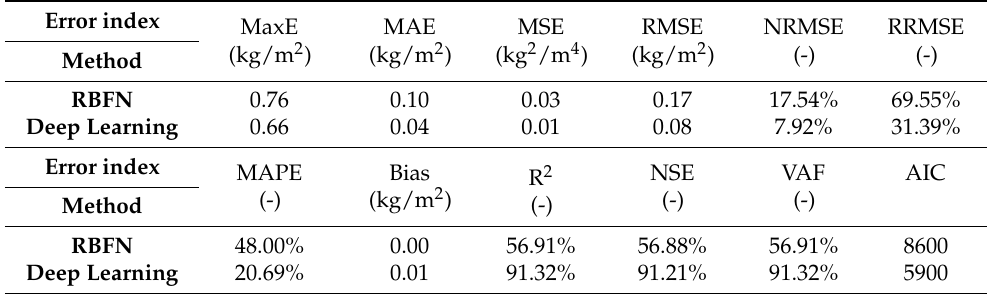
Table 3. Error analysis of interpolated soil water content values using different AI